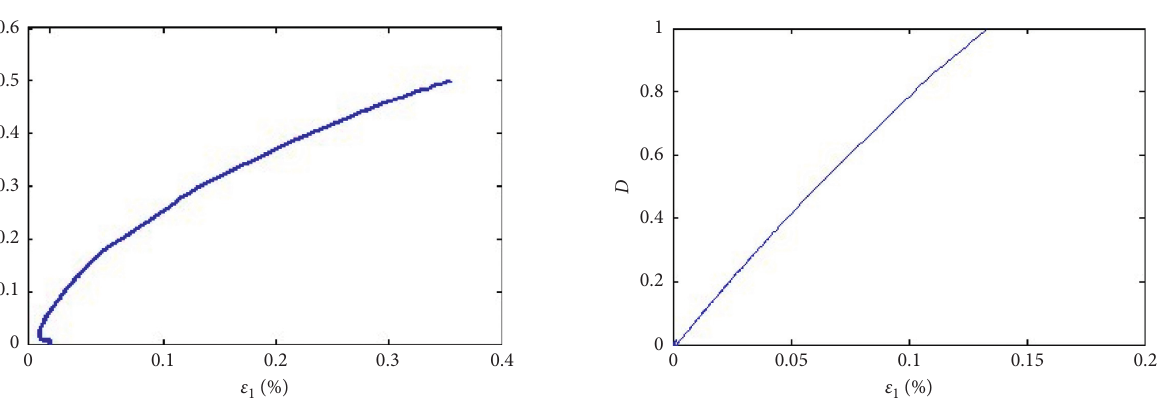
Figure 9: Energy characteristics of sandstone under axial unloading and radial unloading